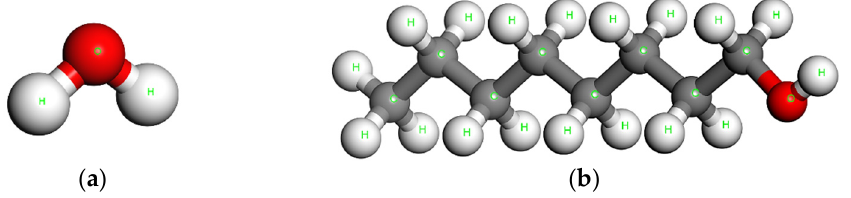
Figure 6. The utilized solvent particles after being optimized: ( a ) Water and ( b ) n-octanol (1-octanol).